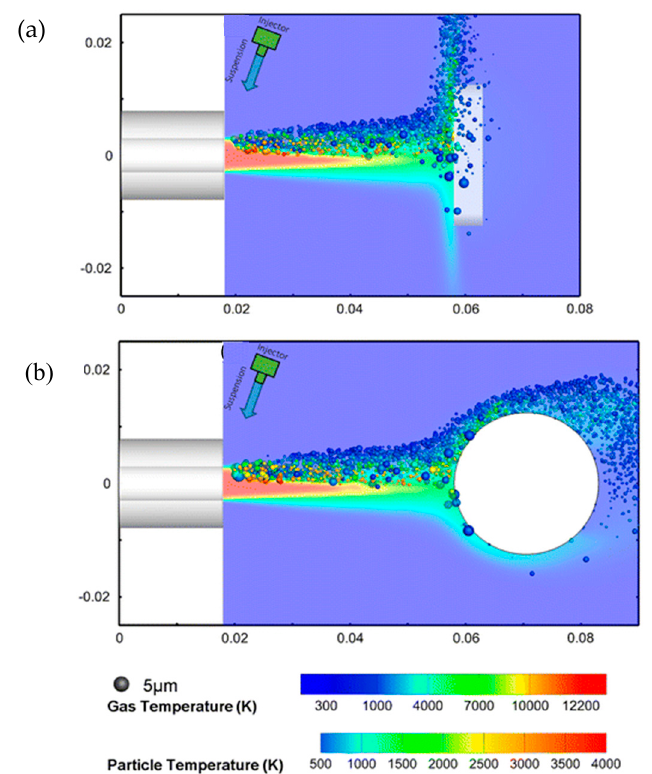
Figure 21. SPS particles trajectories in the vicinity of ( a ) a flat substrate and ( b ) cylindrical substrate (adapted from [23]).